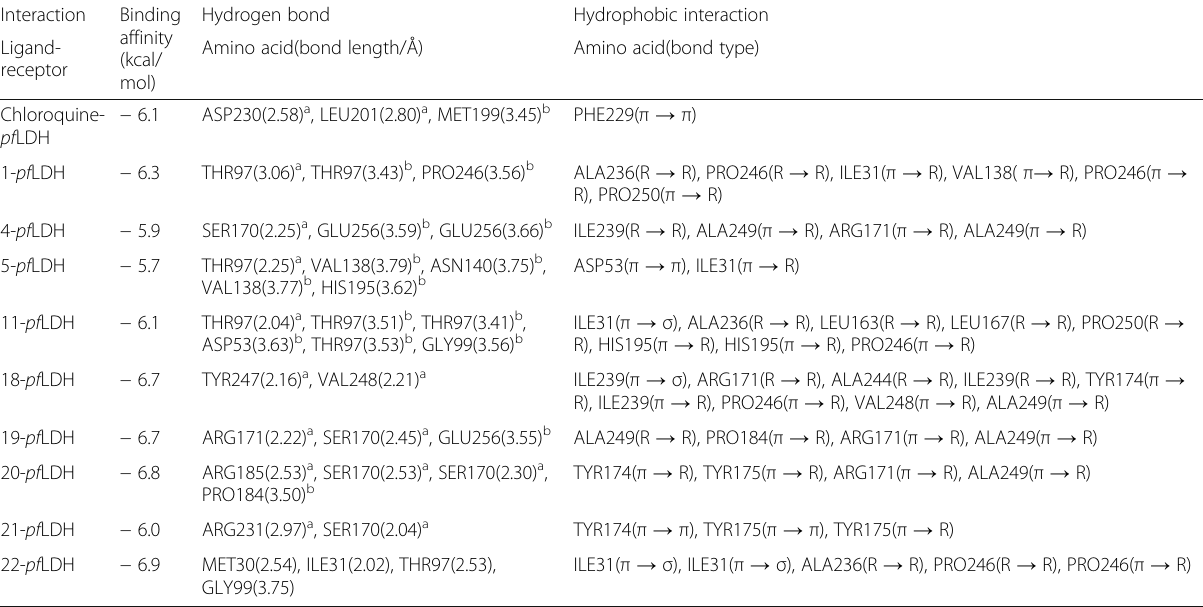
Table 6 Docking result between the selected ligands and pf LDH Interaction